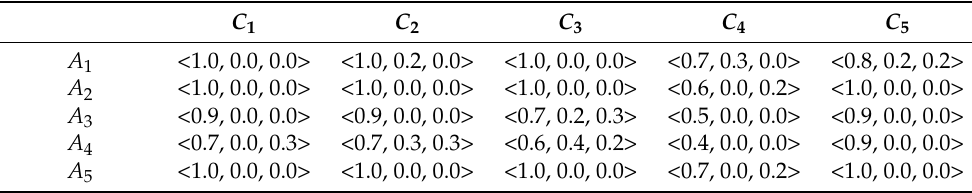
Table 12. The ratings obtained from the first of three respondents.